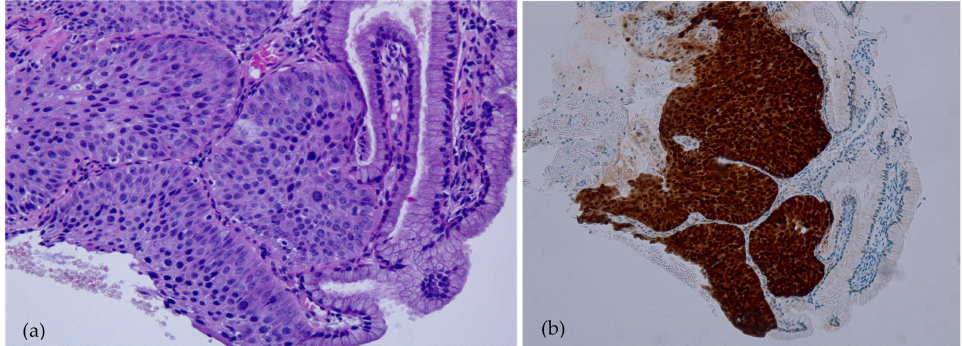
Figure 2. Histopathology image of CIN3/HSIL. The epithelium lacked maturation and con- sisted of highly atypical cells with hyperchromatic nuclei with increased mitotic activity. The nuclear/cytoplasmic ratio was also increased. ( a ) Hematoxylin and eosin staining (magnification 100 × ). ( b ) Immunohistochemical staining with p16 revealed a diffuse reaction, which was highly suggestive of CIN3 (magnification 100 ×